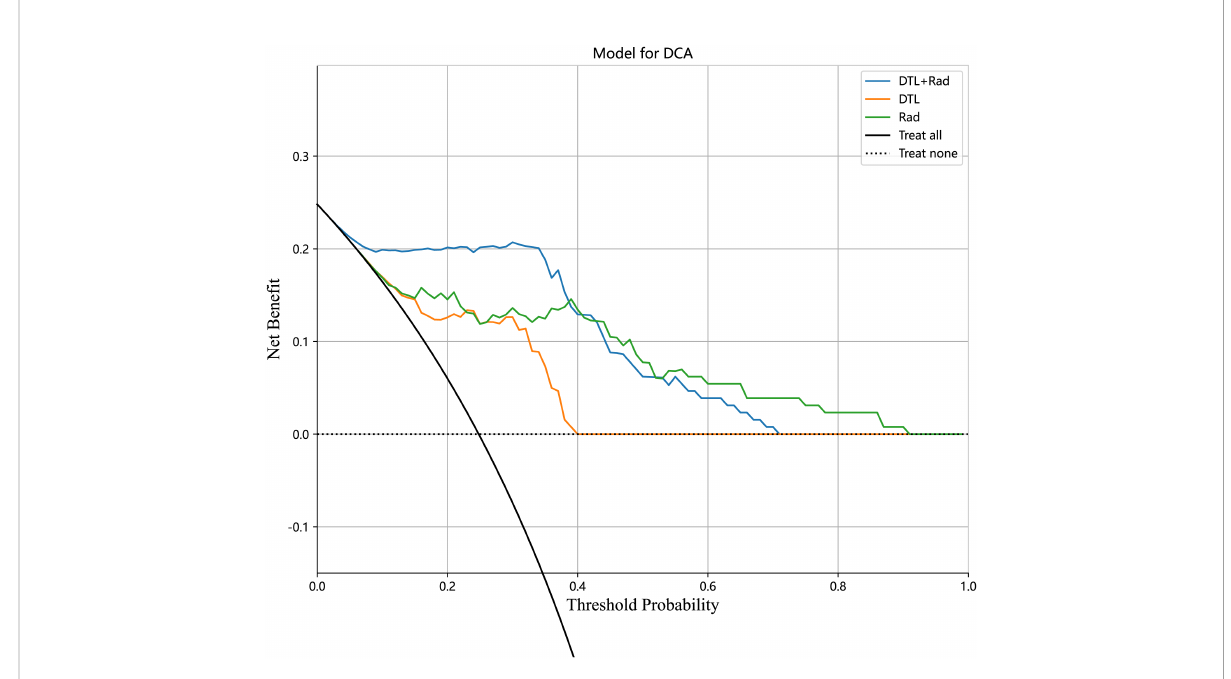
FIGURE 7 The decision curve analysis of all models for patients.